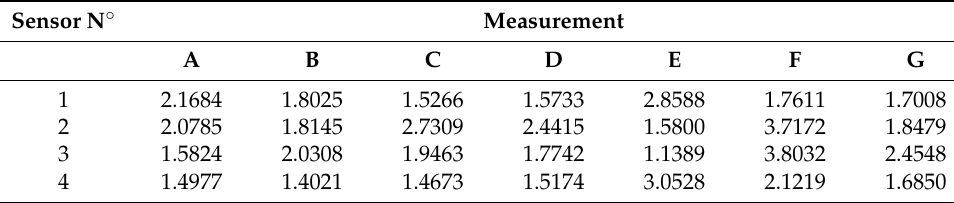
Table 11. RMS of frequency spectrum (10 − 3 ), slab with void below impactor.